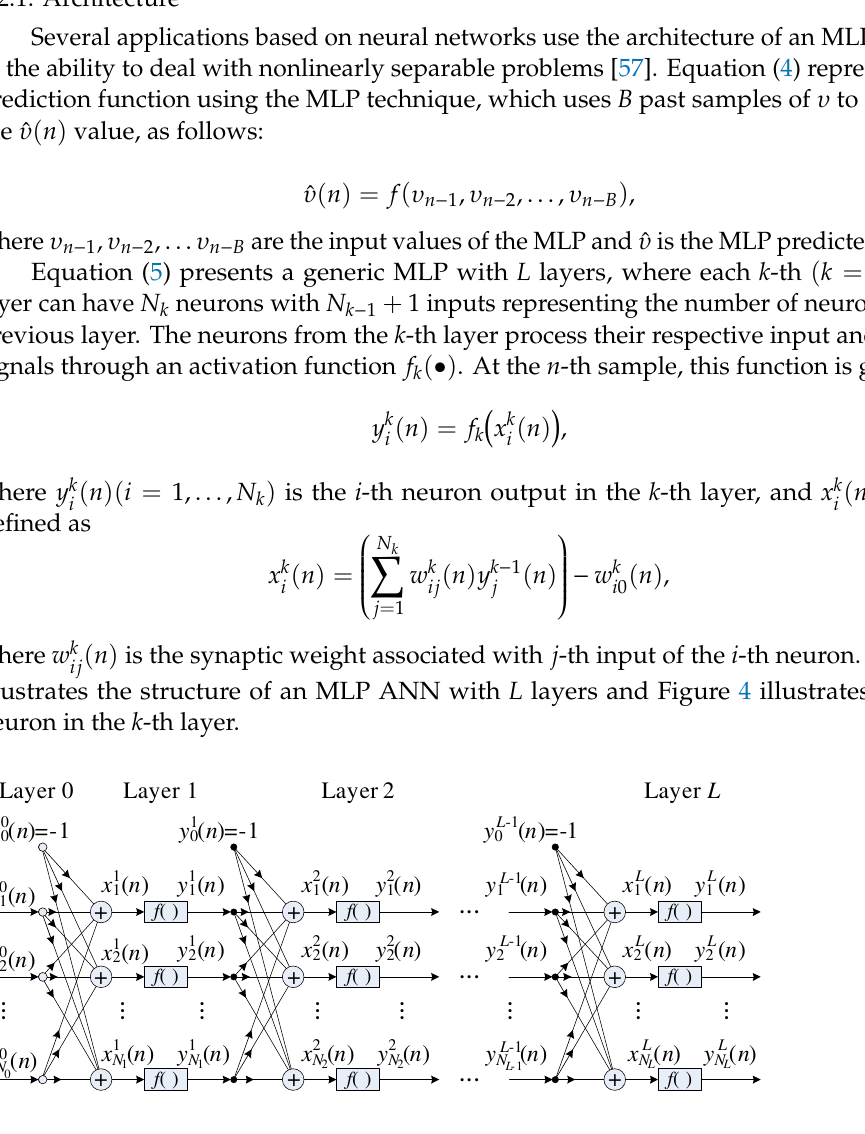
Figure 3. Structure of an MLP artificial neural network (ANN) with L